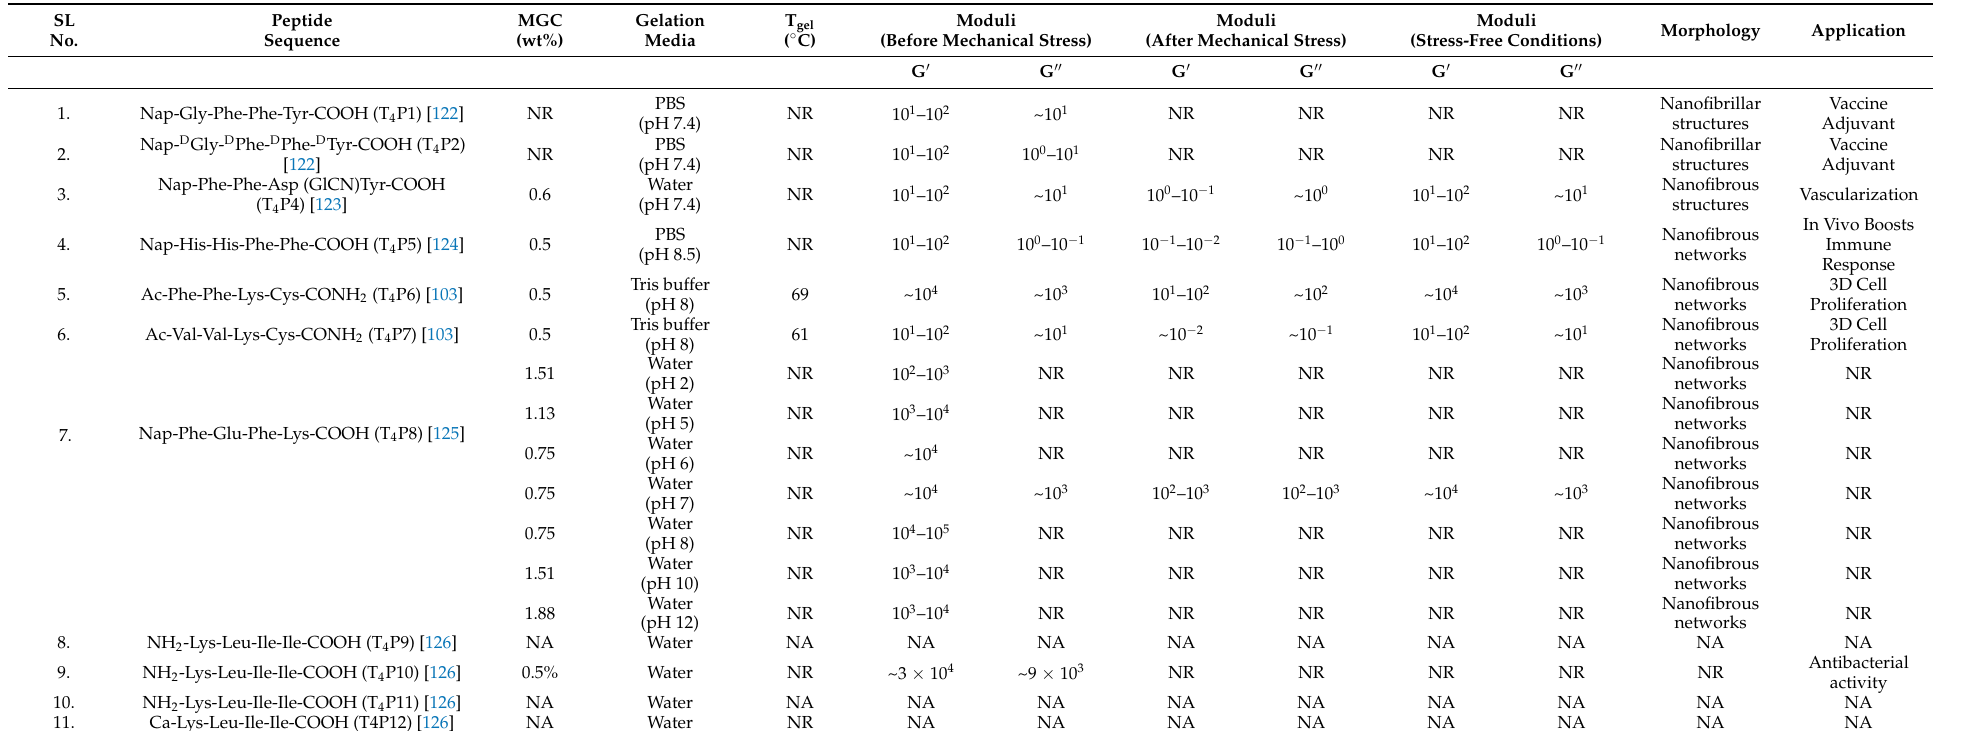
Table 5. List of tetrapeptide (T 4 P)-based thixotropic hydrogelators and respective gelation parameters.